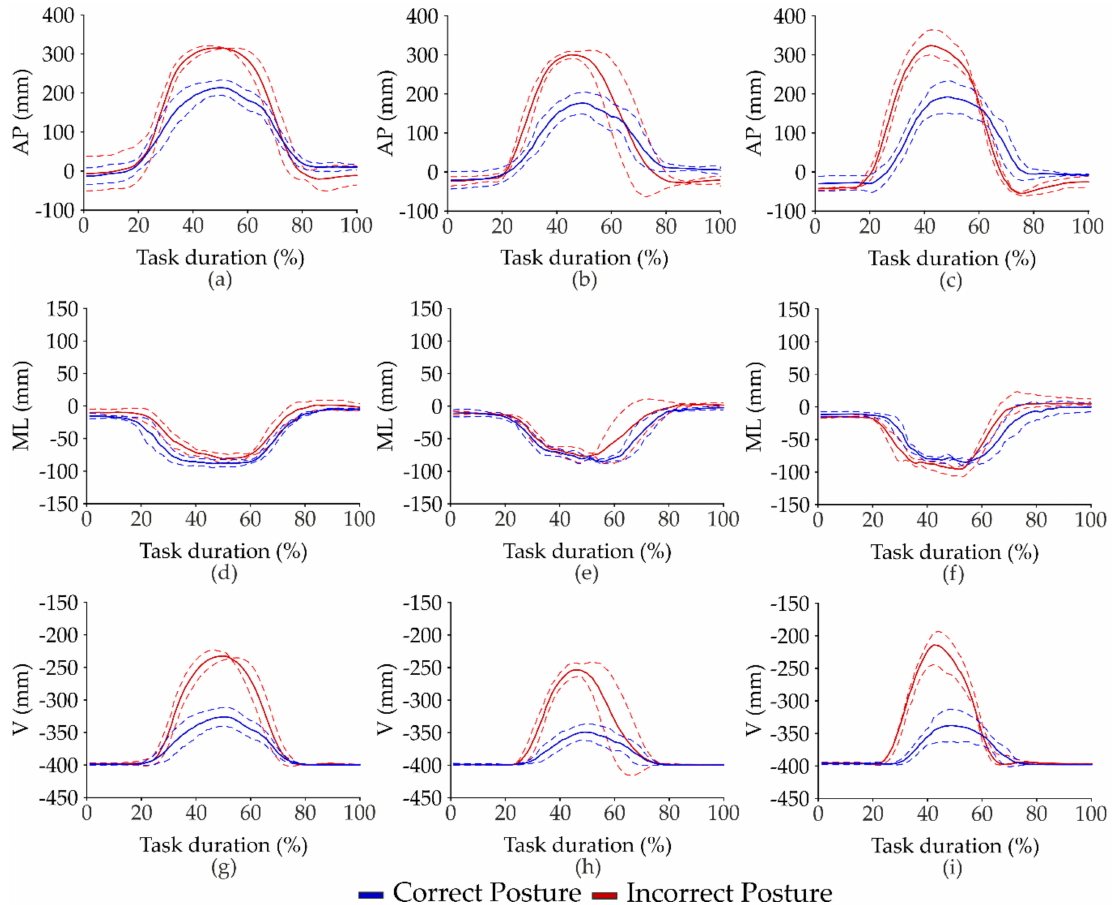
Figure 2. Mean (solid line) and standard deviation (dashed line) values of the range excursion of the displacement of the pl PT trk vector in the AP, ML and V directions with respect to the task duration of a subject performing the CLL and ILL tasks with 1 kg ( a , d , g ), 2kg ( b , e , h ) and 5 kg ( c , f , i )